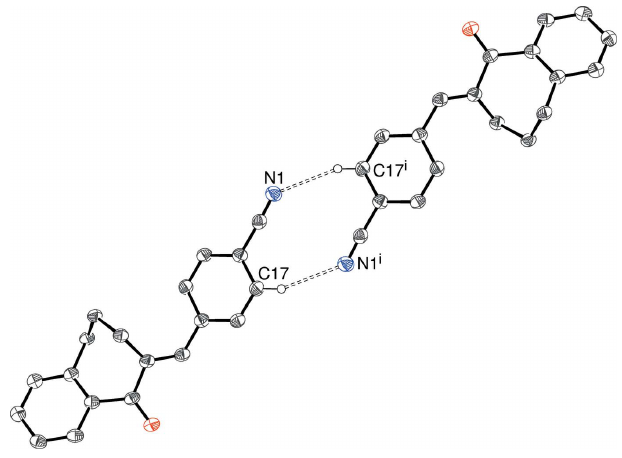
Figure 11 Fragment of the crystal structure of (V), showing inversion dimers linked by pairs of C17—H17 (cid:3)(cid:3)(cid:3) N1 hydrogen bonds. [Symmetry code: (cid:6) x , (cid:6) y + 1, (cid:6) z +